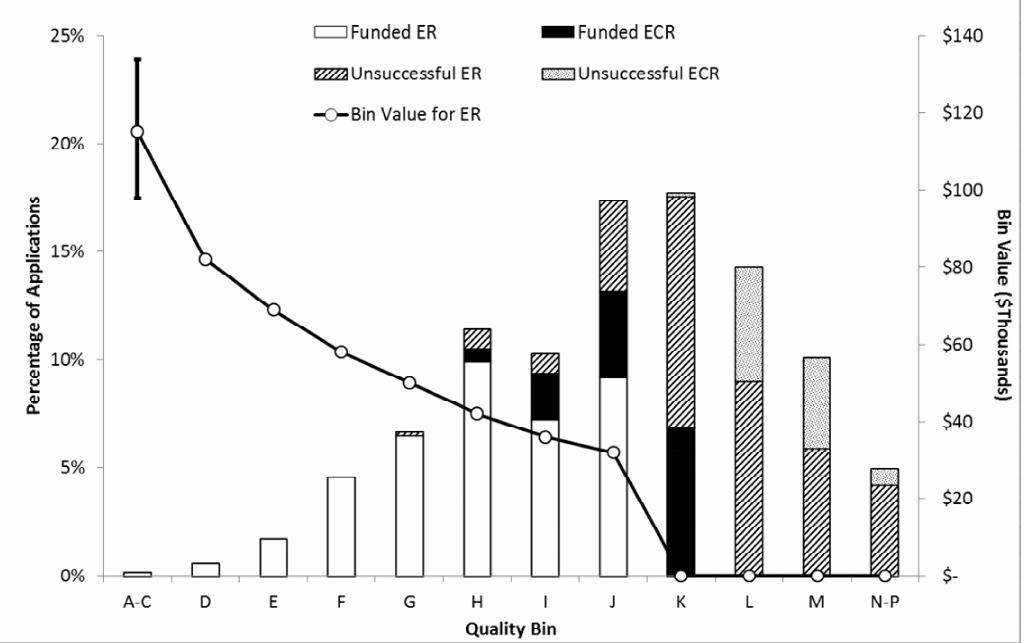
Distribution of the Percentage of Applications by Quality Bin for Each Evaluation Group, 2020 Competition Gene, Cells and